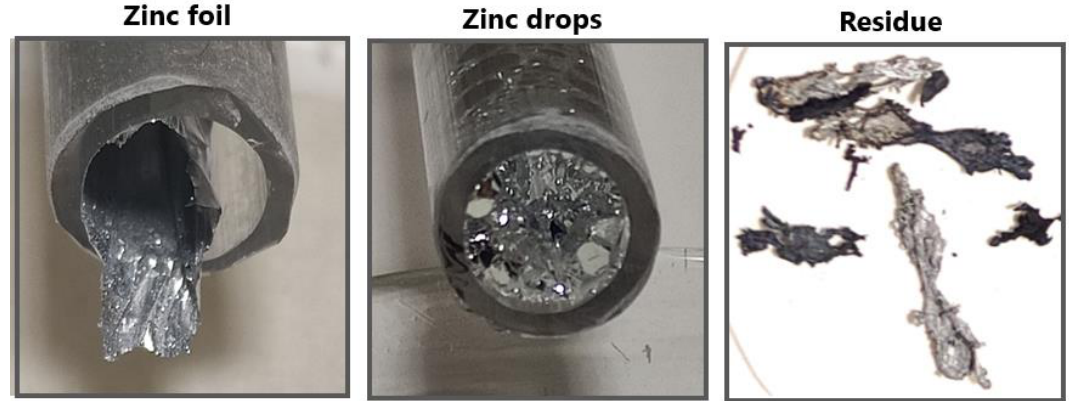
Figure 8. Zinc products (zinc foil, zinc drops) and residue.